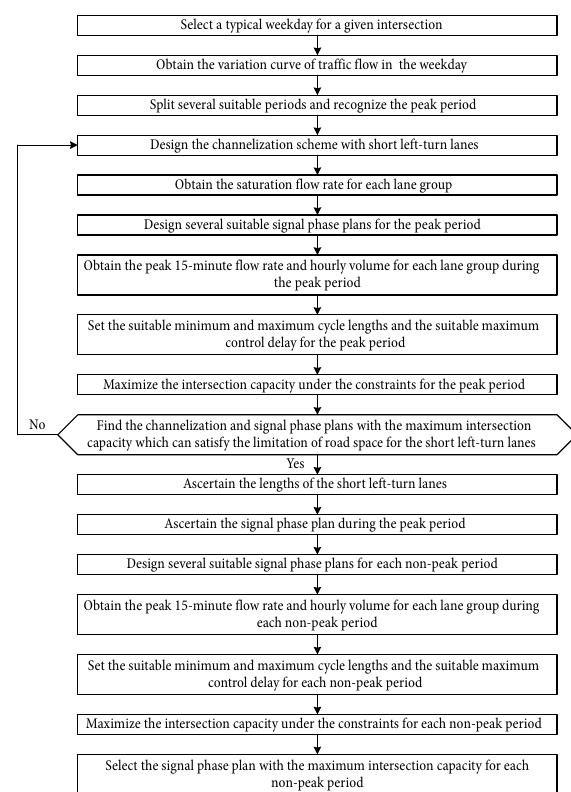
Fig. 6. Procedure for using the proposed model